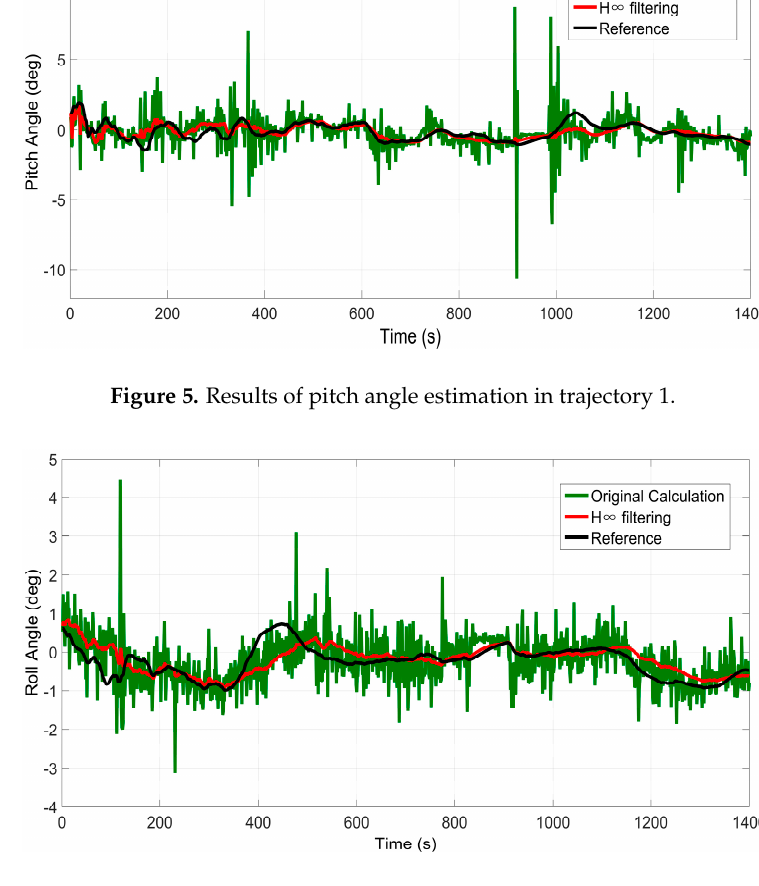
Table 1. Statistics of Angle Errors. Error Item